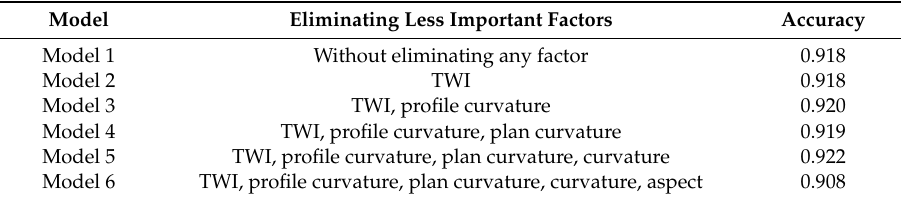
Table 5. The prediction accuracy with elimination of the less important factors.